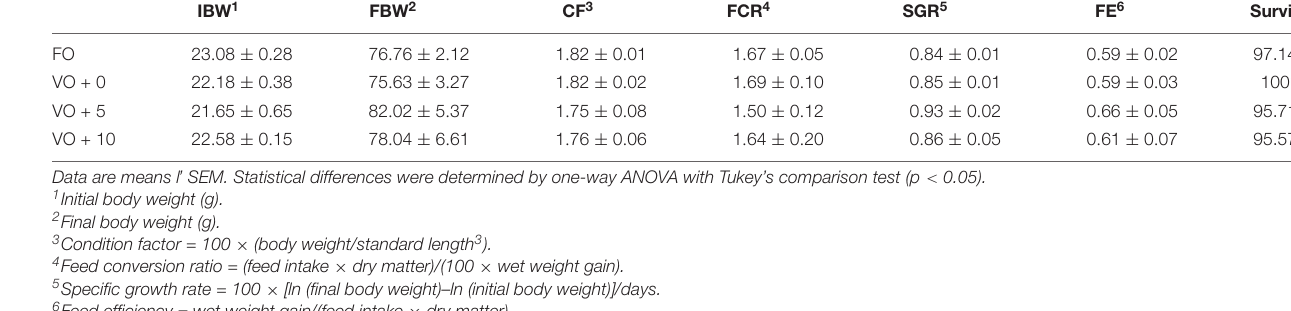
TABLE 6 | Growth performance of European sea bass fed the experimental diets for 21 weeks. IBW 1 FBW 2 CF 3 FCR 4 SGR 5 FE 6 Survival